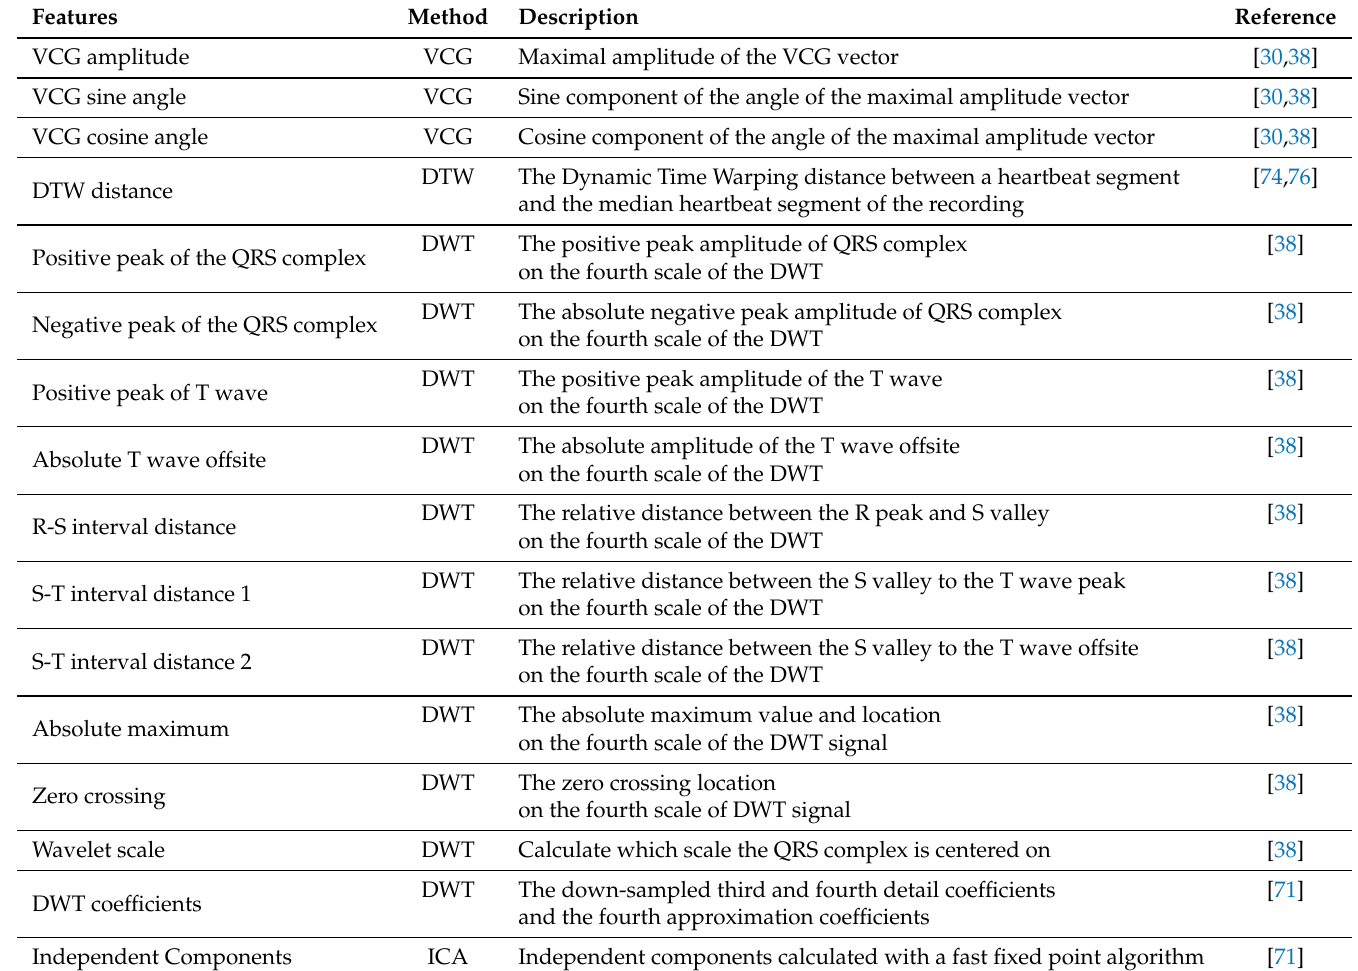
Table 3. Conventional Derived Features of the Heartbeats.